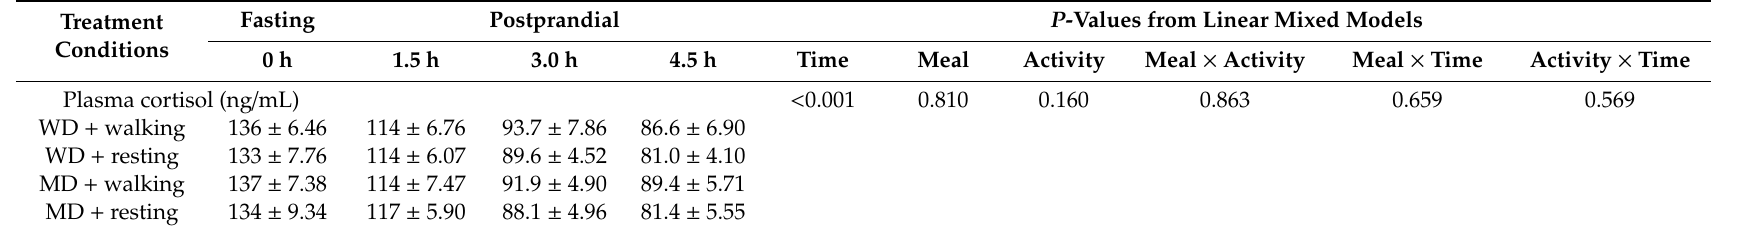
Table 6. Fasting and postprandial plasma cortisol concentration